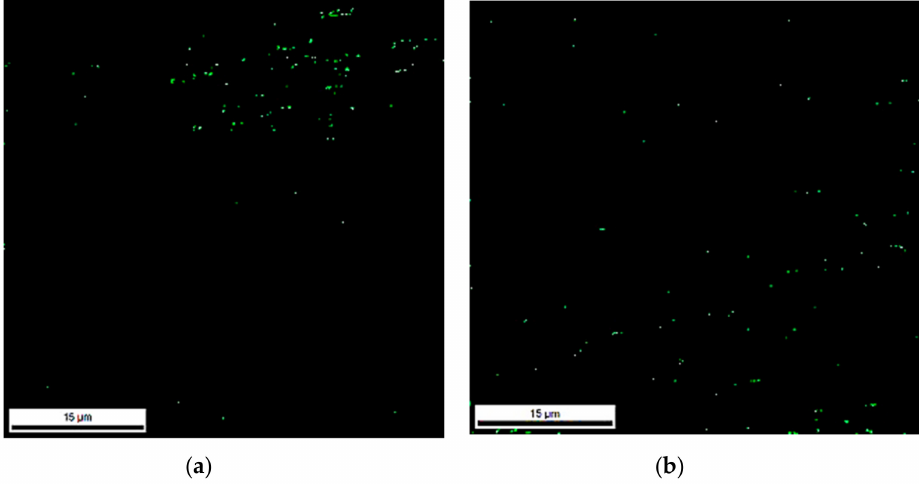
Figure 7. Phase maps by EBSD ( a ) specimen PT- γ -2 and ( b ) specimen PT- γ - 3 . Green areas correspond to retained